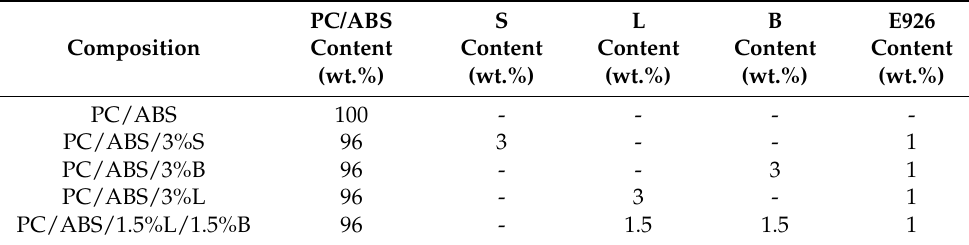
Table 1. Compositional data of the composites.